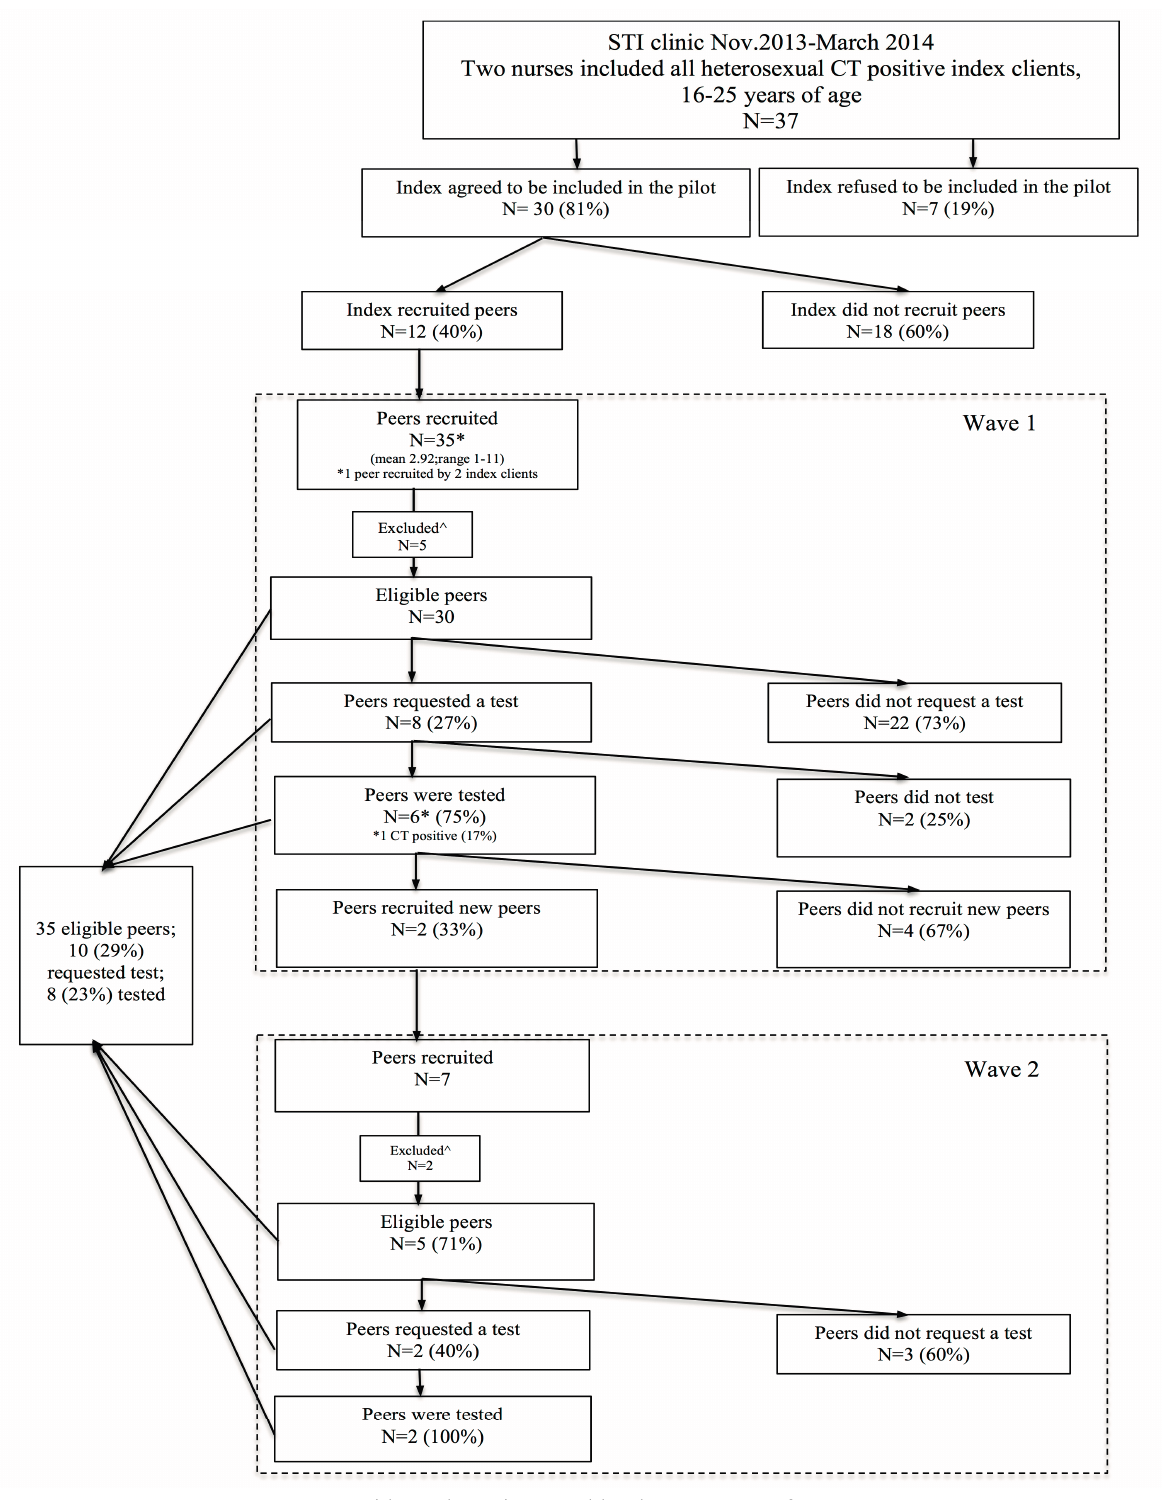
Figure 1. Flowchart of the selection of the study population and recruitment of their